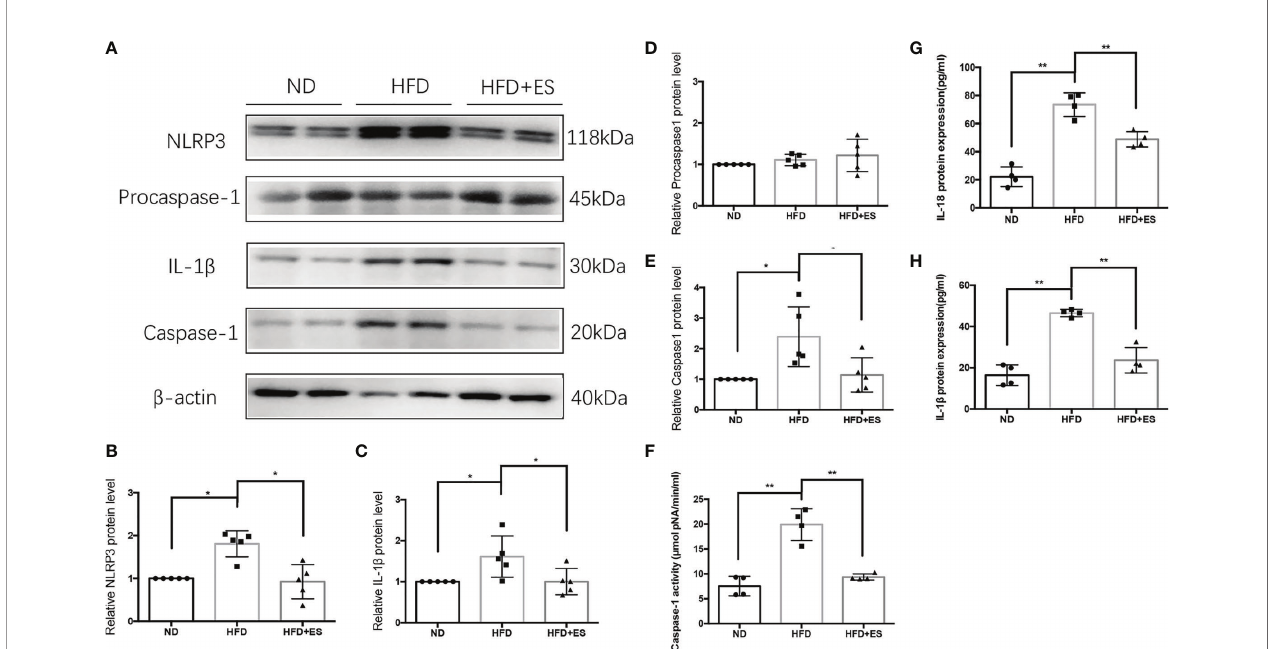
FIGURE 5 | ES regulated NAM via suppression of the NLRP3 in fl ammasome. (A) Immunoblot image showing NLRP3, Procaspase-1, caspase-1, and IL-1 b in the ND, HFD, and HFD+ES groups. (B) Relative NLRP3 protein expression in eWAT (n = 5, * P < 0.05). (C) Relative IL-1 b protein expression in eWAT (n = 5, * P < 0.05). (D) Relative Procaspase-1 protein expression in eWAT (n = 5). (E) Relative caspase-1 protein expression in eWAT (n = 5, * P < 0.05). (F) Relative caspase-1 activity in eWAT (n = 4, * P < 0.05). (G) Relative IL-18 expression in serum (n = 4, ** P < 0.01). (H) Relative IL-1 b expression in serum (n = 4, ** P <